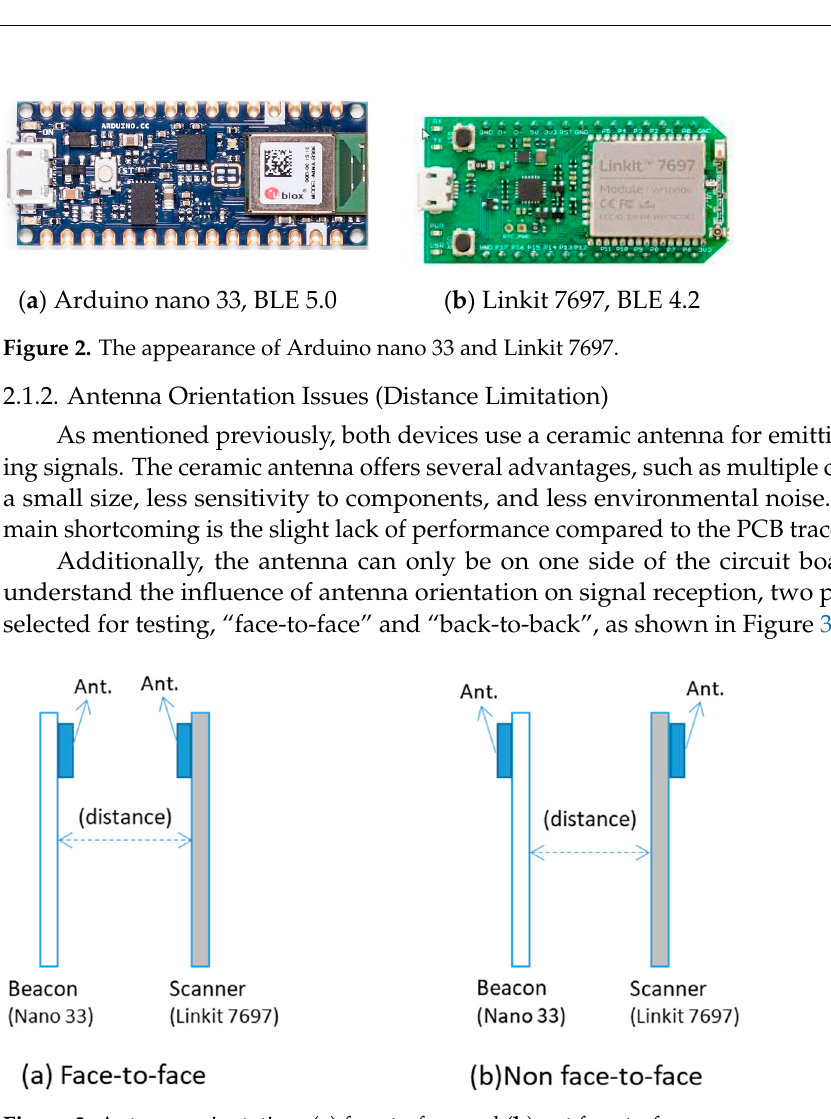
Figure 3. Antenna orientation: ( a ) face-to-face and ( b ) not face-to-face.